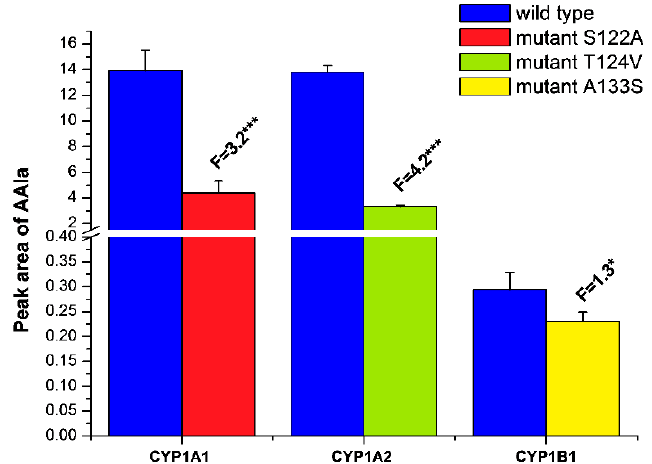
Figure 5. AAI O -demethylation to AAIa catalyzed by human wild-type CYP1A1, 1A2 and 1B1, and their mutants CYP1A1-S122A, CYP1A2-T124V, and CYP1B1-A133S. All CYPs were reconstituted with rat POR in a ratio of 1:1 in liposomes. Data are averages ± SD of three independent measurements ( n = 3). Numbers above columns (“F”) indicate fold changes in O -demethylation of AAI to AAIa catalyzed by wild-type and mutant CYPs. Comparison was carried out by Student t -test; * p < 0.05, *** p < 0.001, different from wild-type CYP enzymes.